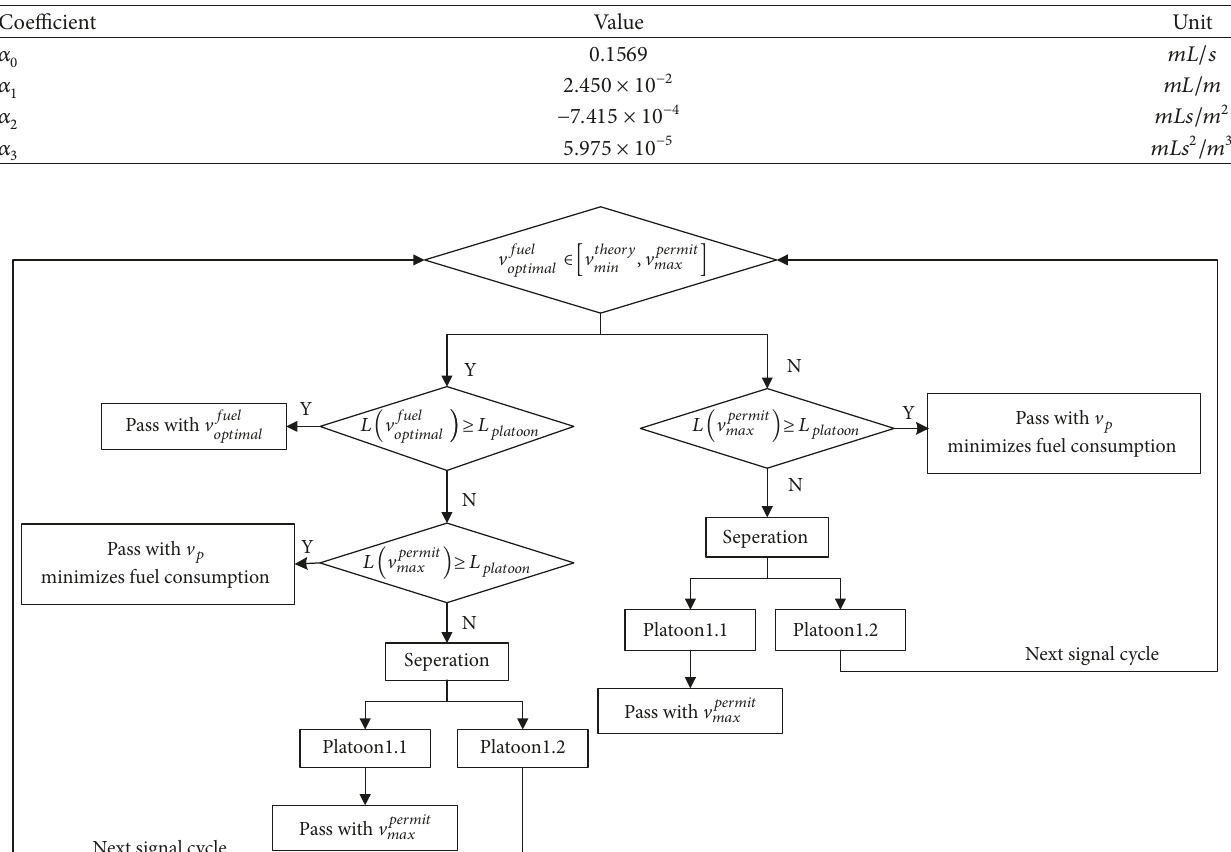
Table 3: Parameters value of fuel consumption.